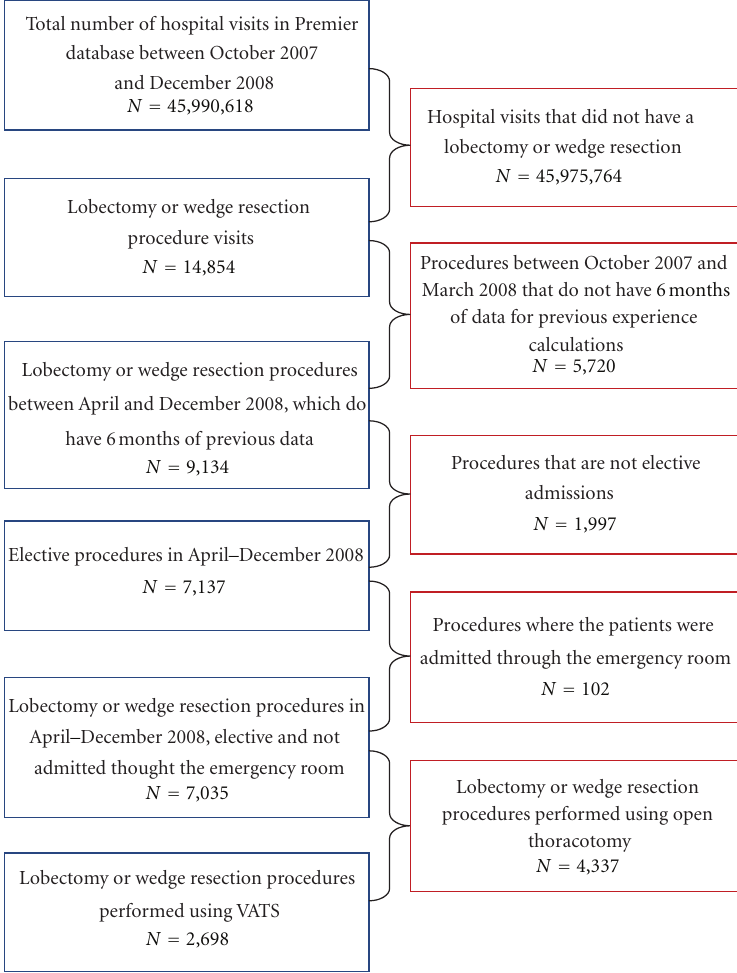
Figure 1: Attrition diagram. Thoracotomy: open versus